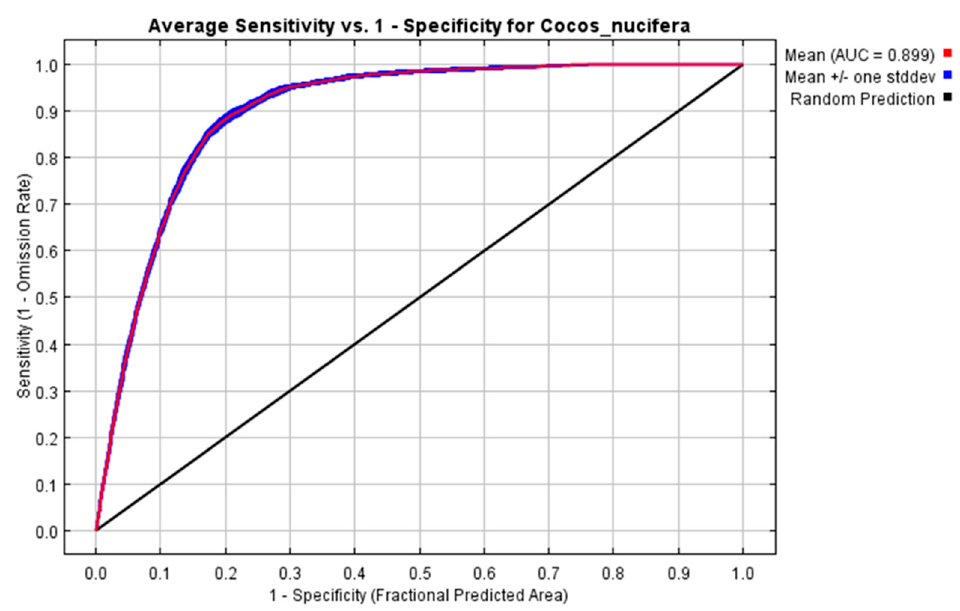
Figure 3. The receiver operating characteristic (ROC) curve. The values shown are the average of 10 replications.